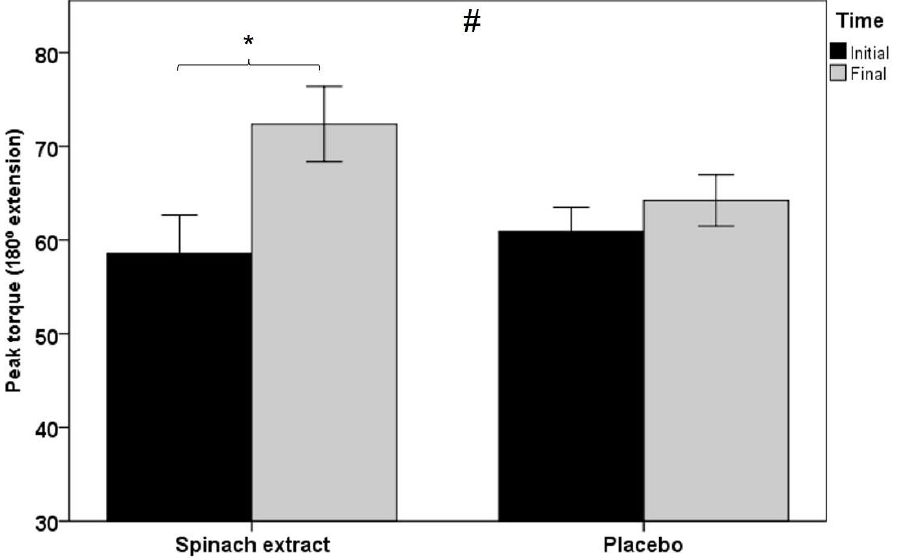
Figure 2. Within-group and between-group differences in peak torque at 180° s −1 knee extension in isokinetic dynamometry testing (error bars ± 1 SD; * p = 0.001; # p = 0.002).